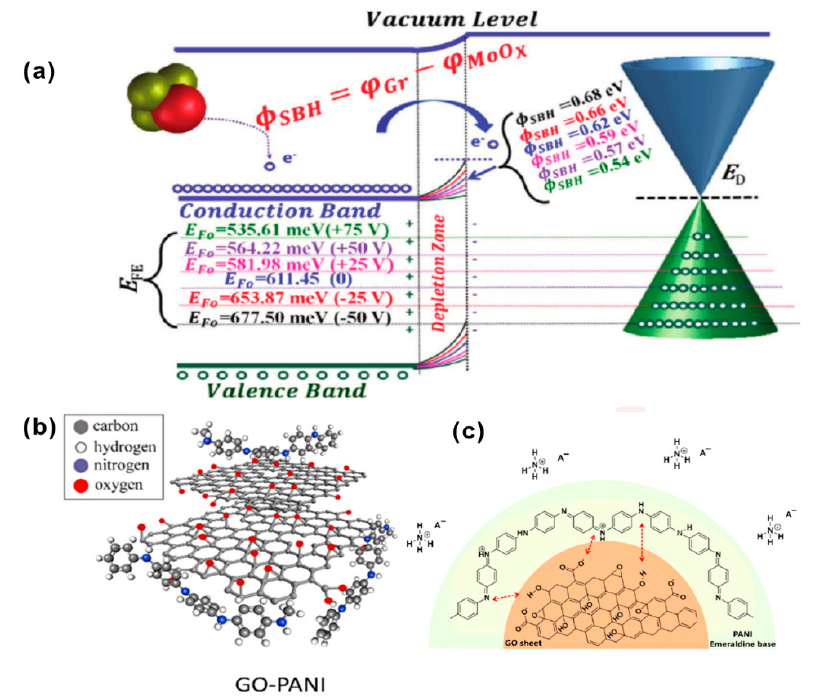
Figure 7. ( a ) Fermi-level tuning diagram in MoOx/graphene composite field-effect transistor sensor (D100) (back gate voltage V GS from − 50 to +75 V, electron transfer from NH3 to p-type graphene) [66]. Copyright (2020), used with permission from Elsevier. ( b ) The expanded coil when PANI nanocomposites were pinned to the GO sheets; ( c ) the adsorption mechanism of GO–PANI in ammonia [68]. Copyright (2021), used with permission from Elsevier.